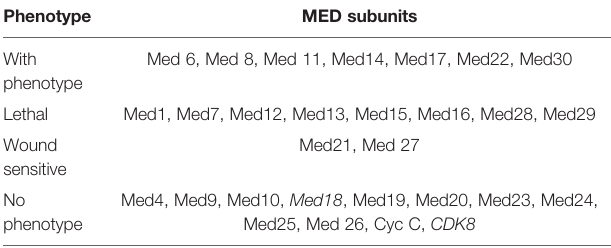
TABLE 2 | Other Med subunits in host defense against A.